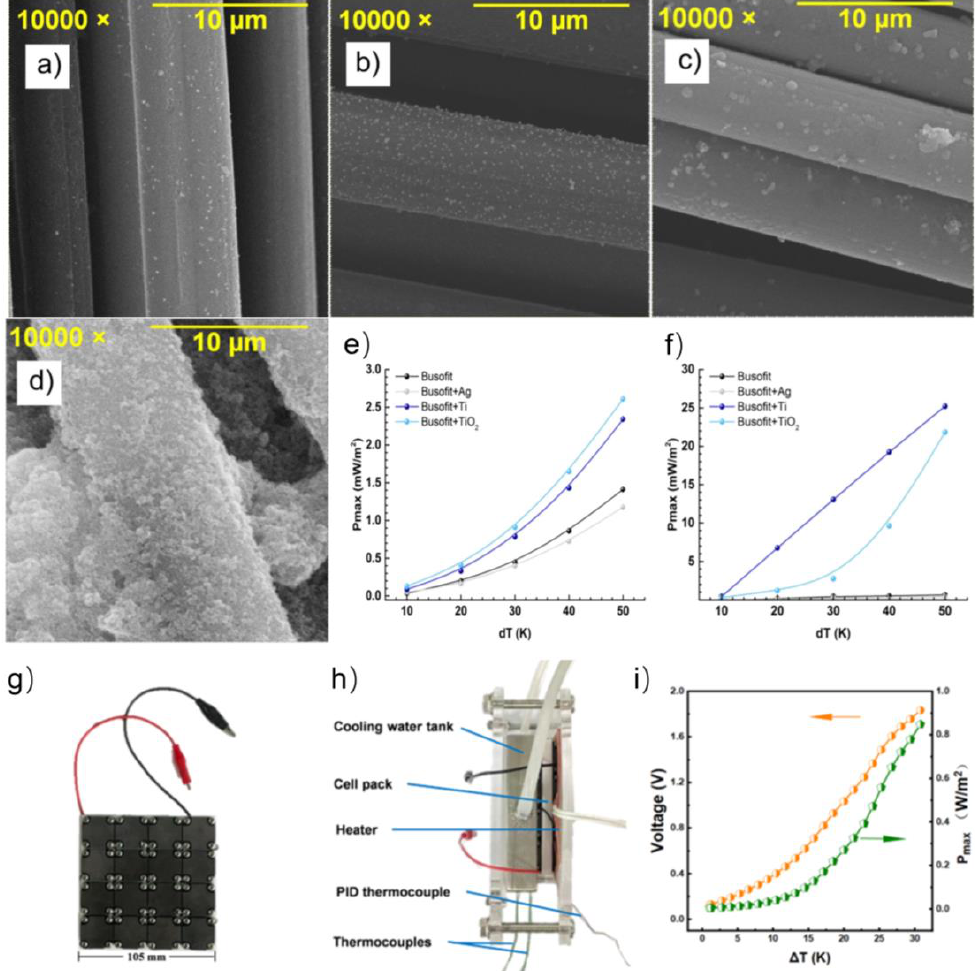
Figure 7. SEM images of the Busofit materials: ( a ) basic; ( b ) with Ag spraying; ( c ) with Ti spraying; ( d ) with infiltrated dispersion of TiO 2 nanoparticles. Plots of maximum power density versus temperature difference between the hot and cold sides of the cell ( e ) for cells with a salt bridge and ( f ) for cells in the coin cell CR2025. (Reproduced with permission from [113]. Copyright 2021 MDPI). Prototype for BST/FeCN 3-/4- thermo–electrochemical cells; ( g ) The prototype consists of 16 cells in series, ( h ) the test system for prototype, and ( i ) thermo–electrochemical performance of the prototype. (Reproduced with permission from [114]. Copyright 2022 Elsevier Ltd.).